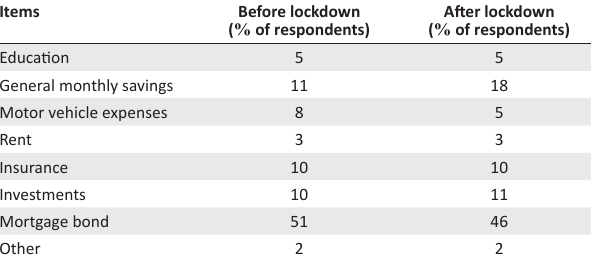
TABLE 5: Monthly income consumption (largest portion). Items Before lockdown After lockdown ( % of respondents) ( % of respondents) Education 5